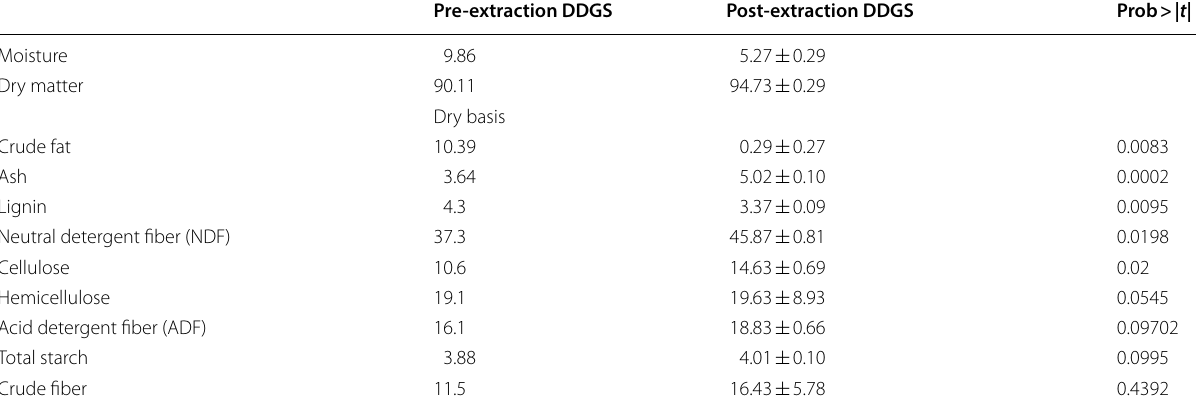
Prob > | t | indicates if there is a significant difference in samples pre- and post-extraction. If Prob > | t | is greater than 0.05, than there is no significant difference and the process does not impact these particular